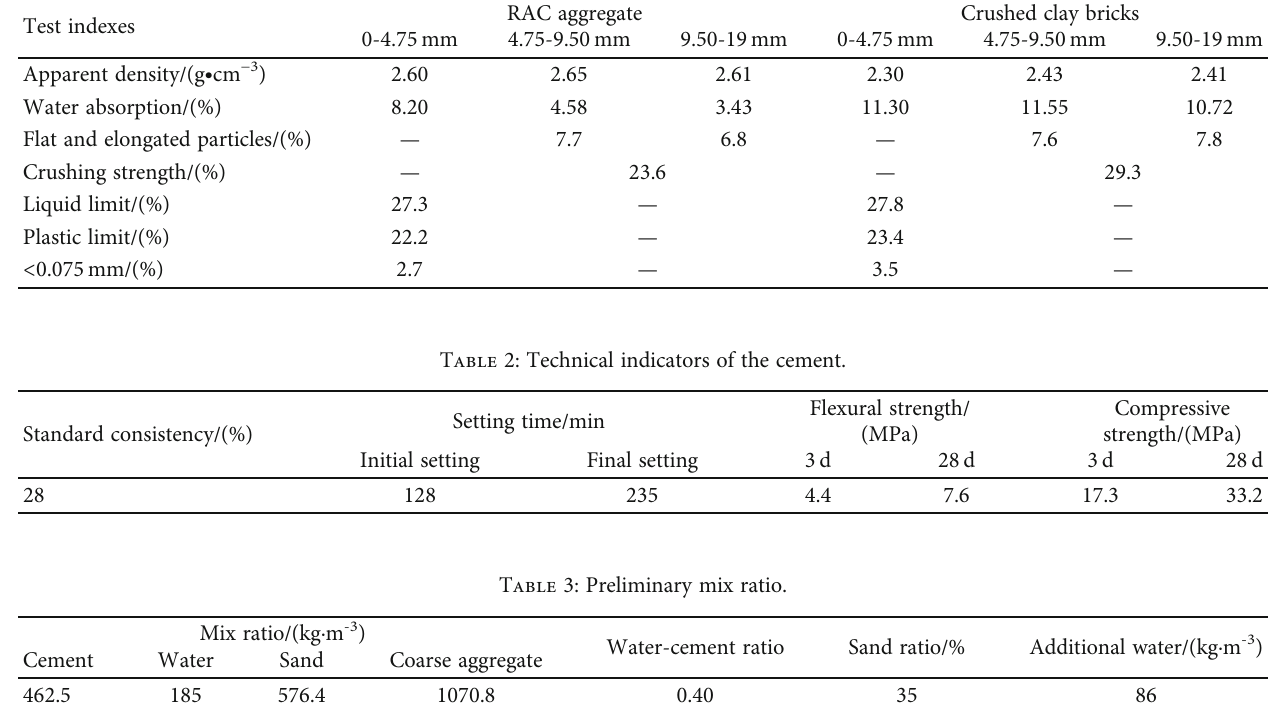
Table 1: Properties of RAC aggregates and crushed clay bricks used in the tests.